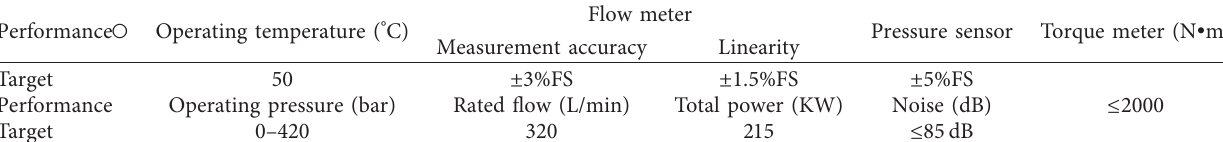
Table 1: The performance parameters of the test